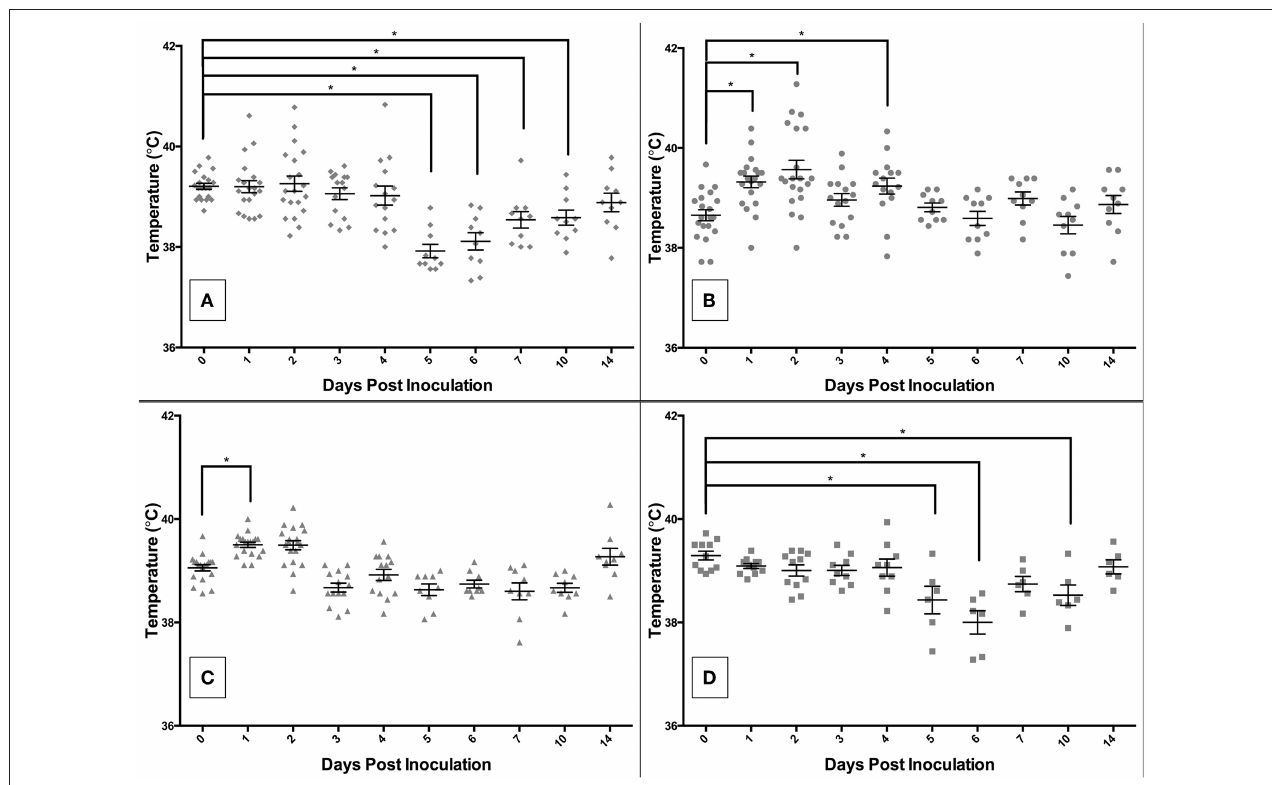
FIGURE 4 | Comparison of rectal temperatures of pigs inoculated with Salmonella serovars 4,[5],12:i:- (A) , Typhimurium (B) , and Derby (C) , and non-inoculated control (D) pigs in animal study #2. Asterisks represent significant differences from the mean temperature on DPI 0 ( p < 0.05). Each datum point represents the temperature in individual animal; short horizontal bar represents mean temperature within a group.